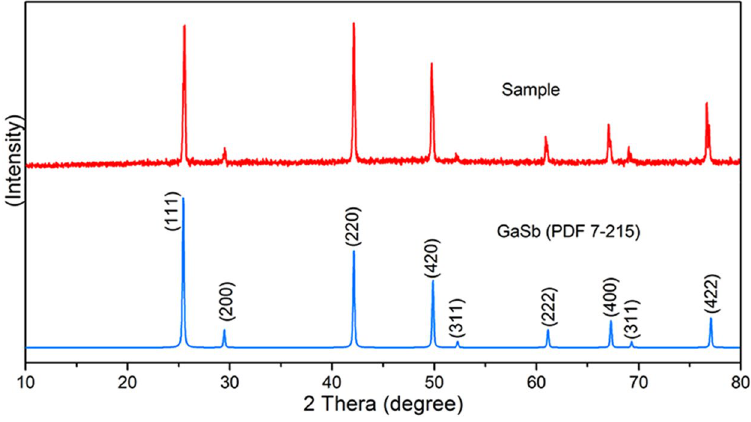
Figure 1. The comparison of XRD spectra of sample after mechanical grinding and PDF card No.